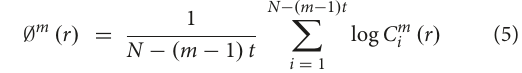
The ApEn criterion indicates the probability that similar patterns are not followed by observations made by subsequent similar observations. A high ApEn value indicates high irregularity in the series, while a low ApEn value indicates a time series with multiple repetitive patterns. Having a time series such as X = { x i , i = 1 , 2 , ..., N } , where N is the length of the time series, ApEn is computed using several consecutive steps.